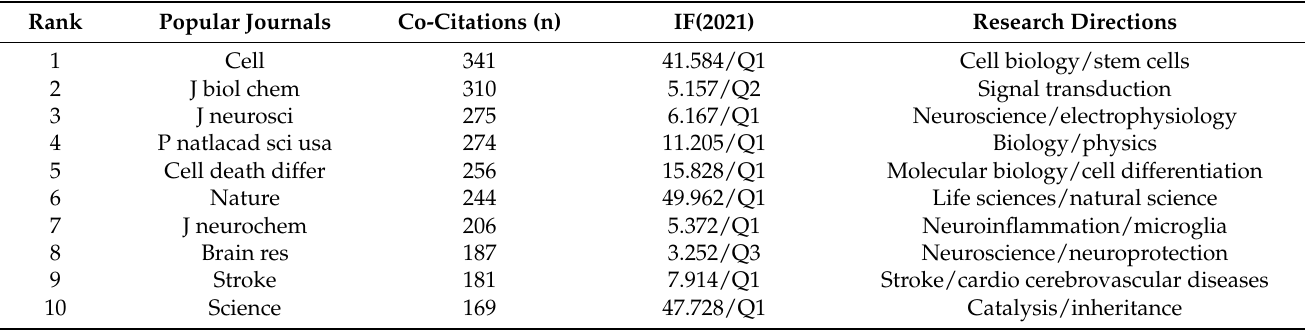
Table 1. Top 10 journals with the highest co-citations in articles reported on necroptosis in the field of neuroscience.